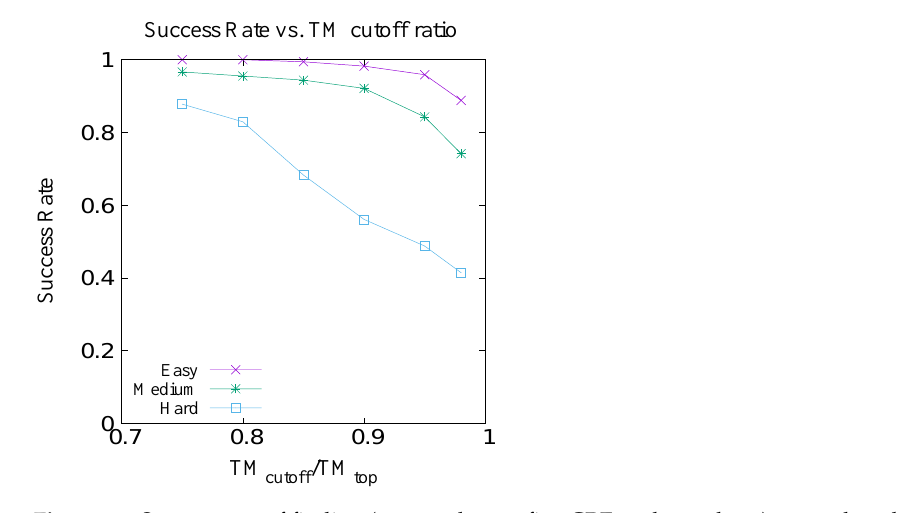
Figure 18. Success rate of finding (among the top five CRFpred templates) a template that is within a certain cutoff ratio of the maximal possible TM score for three subsets of Easy, Medium and Hard